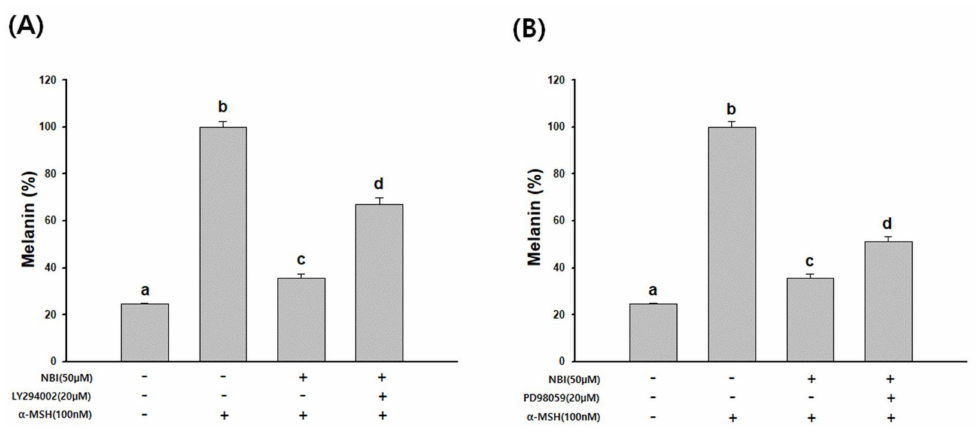
Figure 8. E ff ects of NBI on the regulation of Akt / GSK-3 β and MEK / ERK signaling pathways. Melanin contents were evaluated. B16F10 cells were co-treated with NBI and specific inhibitors of ( A ) MEK / ERK (PD98059) and ( B ) Akt / GSK-3 β (LY294002) signaling. Cells were stimulated with α -MSH (100 nM) and pretreated for 1 h in the absence ( − ) or presence ( + ) of Akt / GSK-3 β and MEK / ERK pathway-specific inhibitor, and then cultured without ( − ) or with ( + ) 50 µ M NBI for 48h. Data are presented as mean ± SD. Values with di ff erent letters (a, b, c, d) are significantly di ff erent one from another (one-way ANOVA followed by Tukey’s multiple range test, p < 0.05).